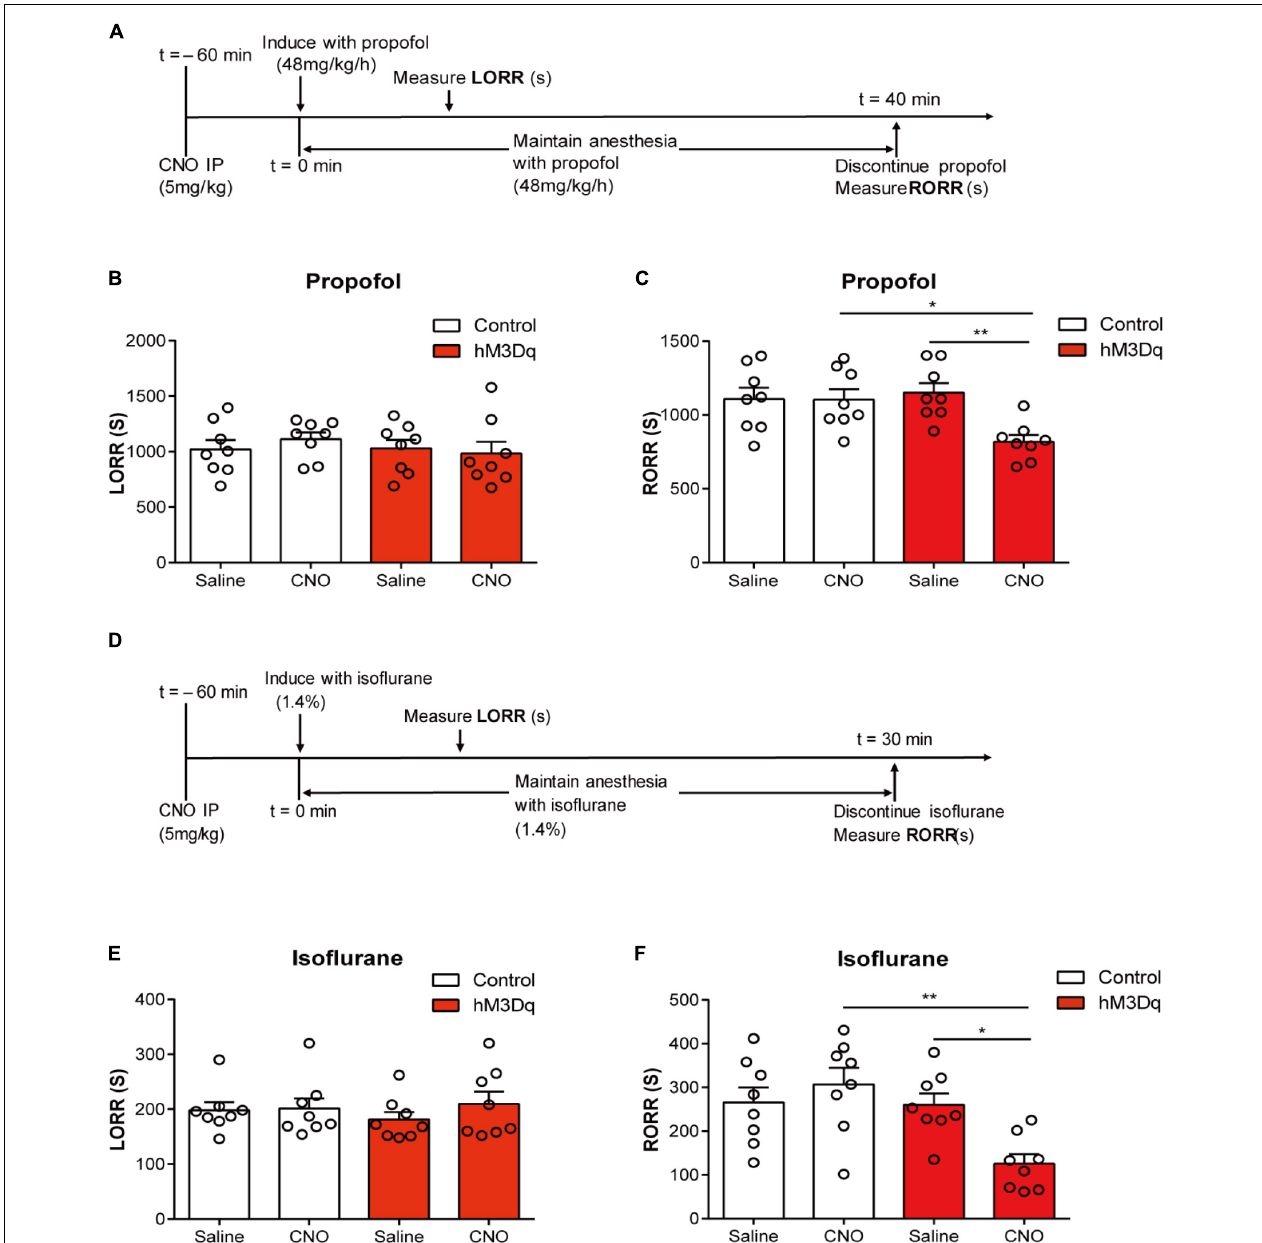
FIGURE 3 | PBN activation accelerates emergence from general anesthesia. (A) Timeline for quantifying changes in induction and recovery time with propofol. (B) Results of propofol inducing LORR time in the control group (AAV-hSyn-EGFP) and the hM3Dq group (AAV-hSyn-hM3Dq-EGFP), both of which received saline or CNO injection respectively. The hM3Dq animals injected with CNO do not show a significant difference ( p = 0.4214, F 1 , 28 = 0.6659, two-way ANOVA) in induction time relative to each of the other three groups. (C) The hM3Dq animals injected with CNO show a significant decrease in recovery time relative to hM3Dq-saline rats ( p = 0.0066) and control-CNO rats ( p = 0.0103) in propofol anesthesia (Bonferroni’s post hoc test after two-way ANOVA). (D) Timeline for quantifying changes in induction and recovery time with isoflurane. (E) The hM3Dq animals injected with CNO do not show a significant difference ( p = 0.1844, F 1 , 28 = 1.852, two-way ANOVA) in induction time of isoflurane anesthesia. (F) The hM3Dq rats injected with CNO show a significant decrease in recovery time relative to hM3Dq-saline rats ( p = 0.0263) and control-CNO rats ( p = 0.0016) in isoflurane anesthesia (Bonferroni’s post hoc test after one-way ANOVA). All summary graphs show mean ± SEM; n = 8 for each group. ∗ p < 0.05 and ∗∗ p <